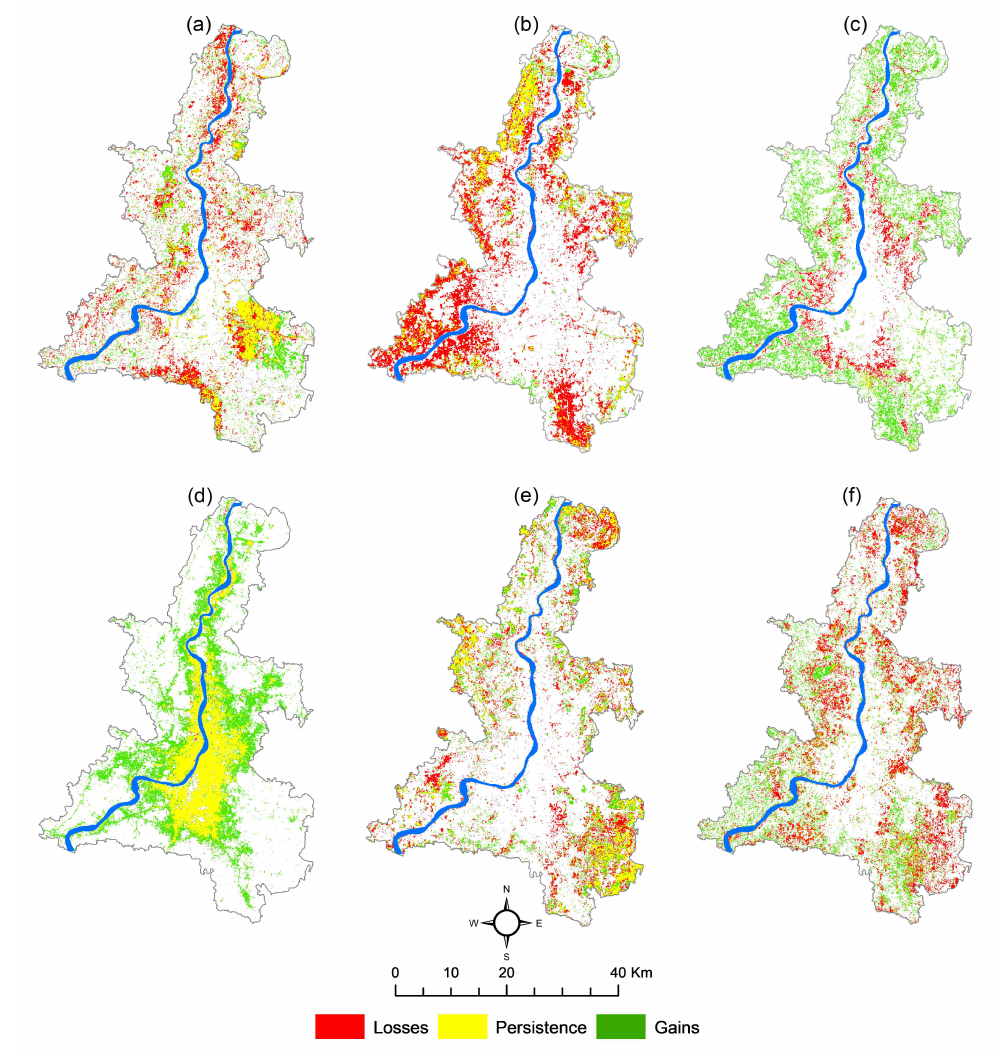
Figure 6. The spatial trend in gains and losses in the LULCs of KMA between 1996 and 2016; ( a ) gains, losses, and persistence in water bodies, ( b ) gains, losses, and persistence in vegetation, ( c ) gains, losses, and persistence in mixed built-up, ( d ) gains, losses, and persistence in built-up, ( e ) gains, losses, and persistence in agricultural land, and ( f ) gains, losses, and persistence in bare